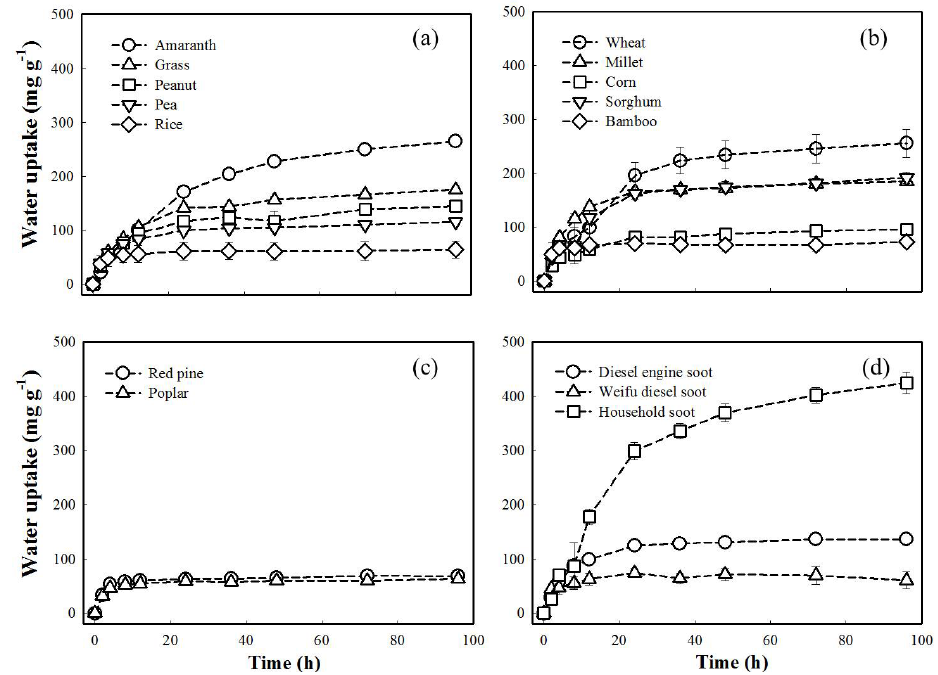
Figure 4. Sorption kinetics of water vapor plotted as water uptake (mgg − 1 ) vs. time (h) at 94% relative humidity. (a) Subgroup 1 of herbal BCPs. (b) Subgroup 2 of herbal BCPs. (c) Woody BCPs. (d) Soot. Error bars represent standard variations from duplicate